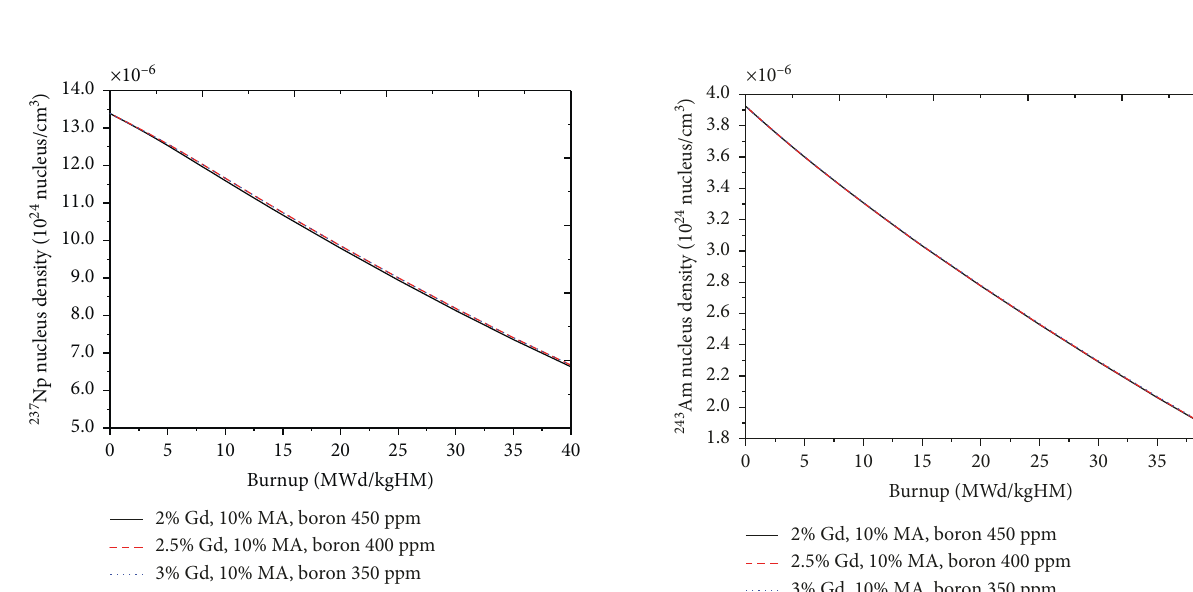
Figure 14: Transmutation of 241 Am versus burnup when loading 10wt.% of MAs.